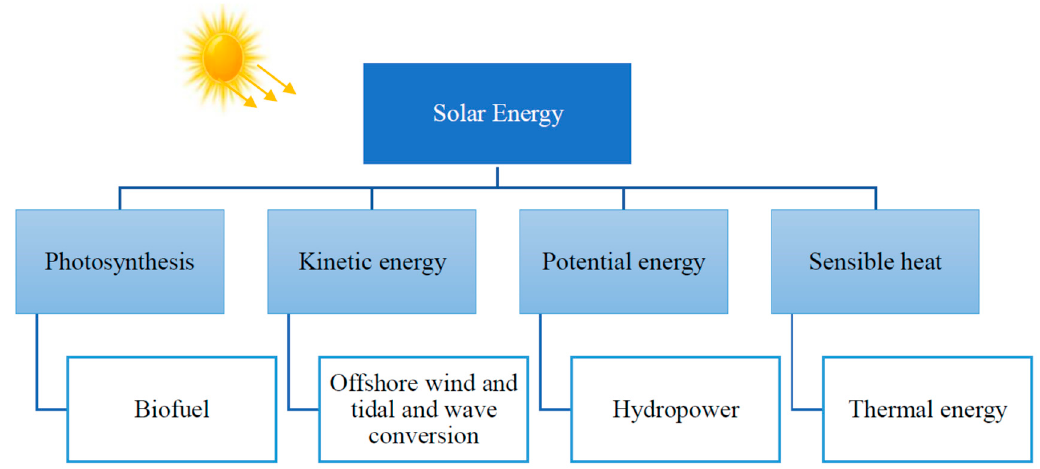
Figure 3. Continuous flow of solar energy on Earth.